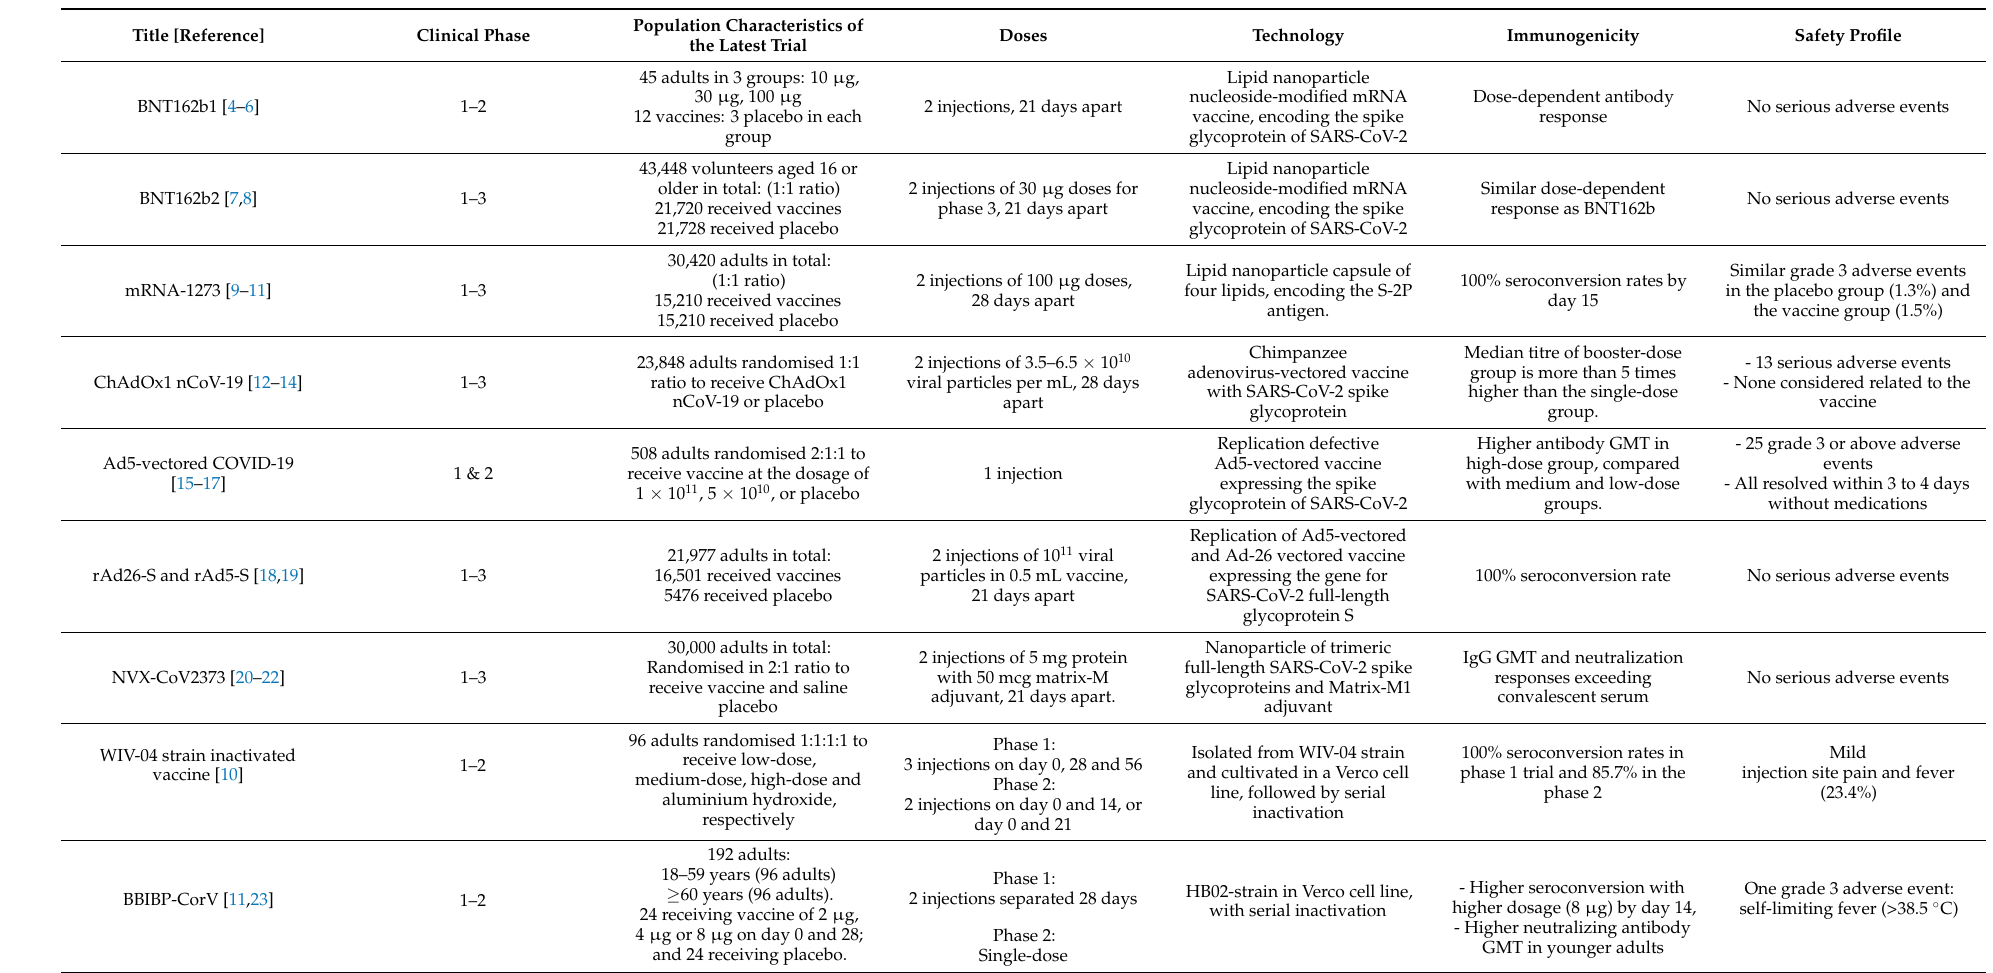
Table 1. Summary of vaccine